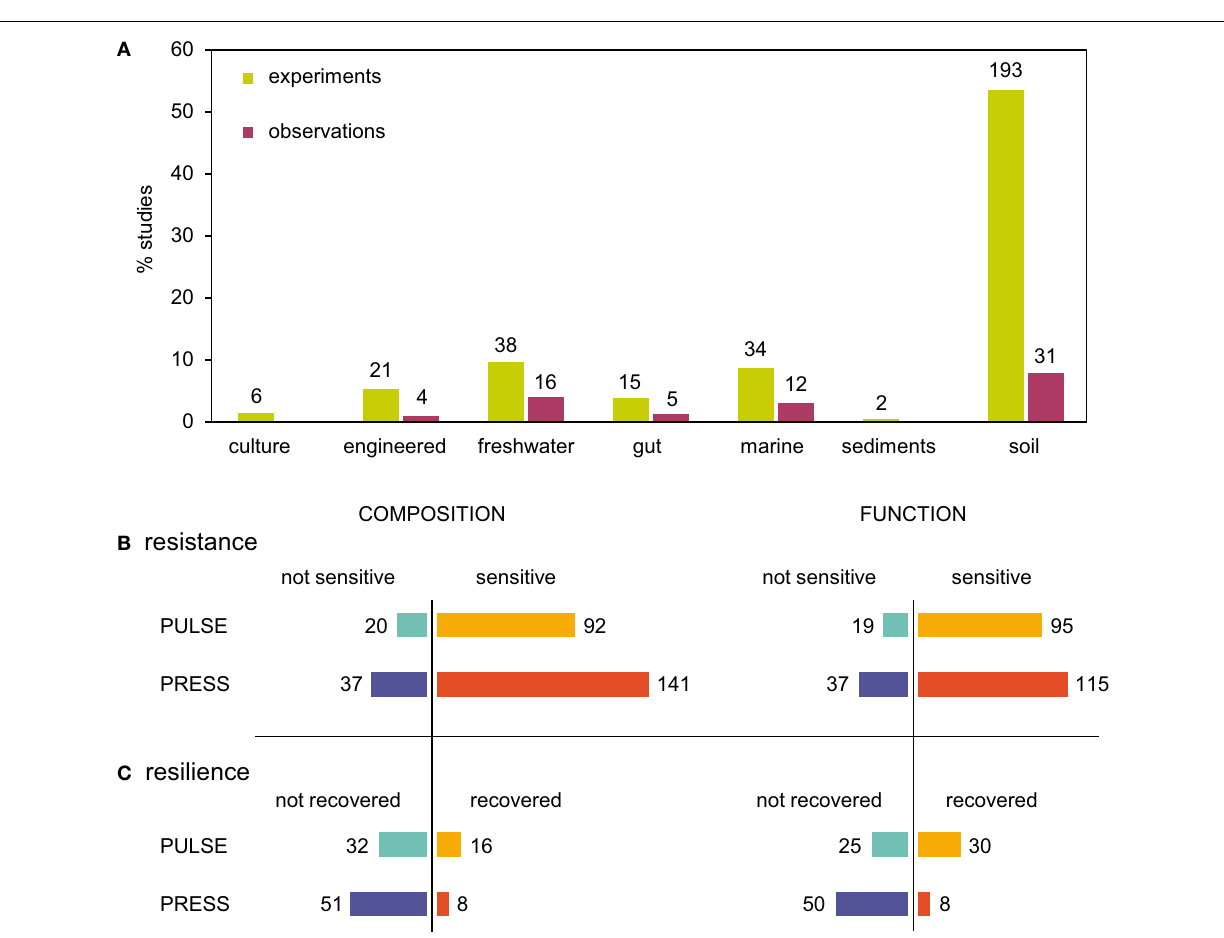
FIGURE 3 | Summary of a literature survey of microbial community responses to pulse and press disturbances. The survey included studies that investigated changes in microbial community structure after biological, chemical, or physical disturbances. (A) Representation of investigations across ecosystem types, and by whether the investigation was a designed experiment or opportune in situ observations after a disturbance.There were 378 total investigations from 247 total studies, as some studies investigated